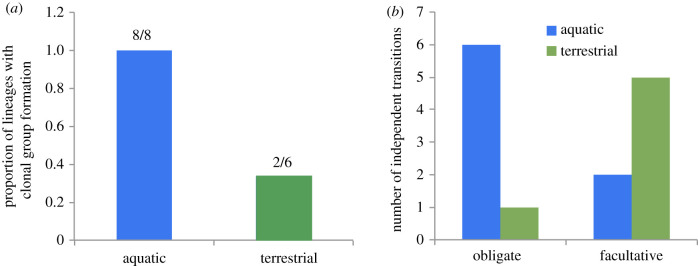
The origins of multicellularity in different environments. (a) The proportion of lineages that have clonal group formation that originated in aquatic and terrestrial environments. All multicellular lineages that originated in the sea have clonal group formation (8 out of 8 lineages), whereas only some of the multicellular lineages that originated on land have clonal group formation (2 out of 6). (b) Multicellular lineages that originated in water more commonly evolve obligate multicellularity (6 out of 8 lineages) compared to lineages that originated on land, which more often remain facultatively multicellular (5 out of 6 lineages).